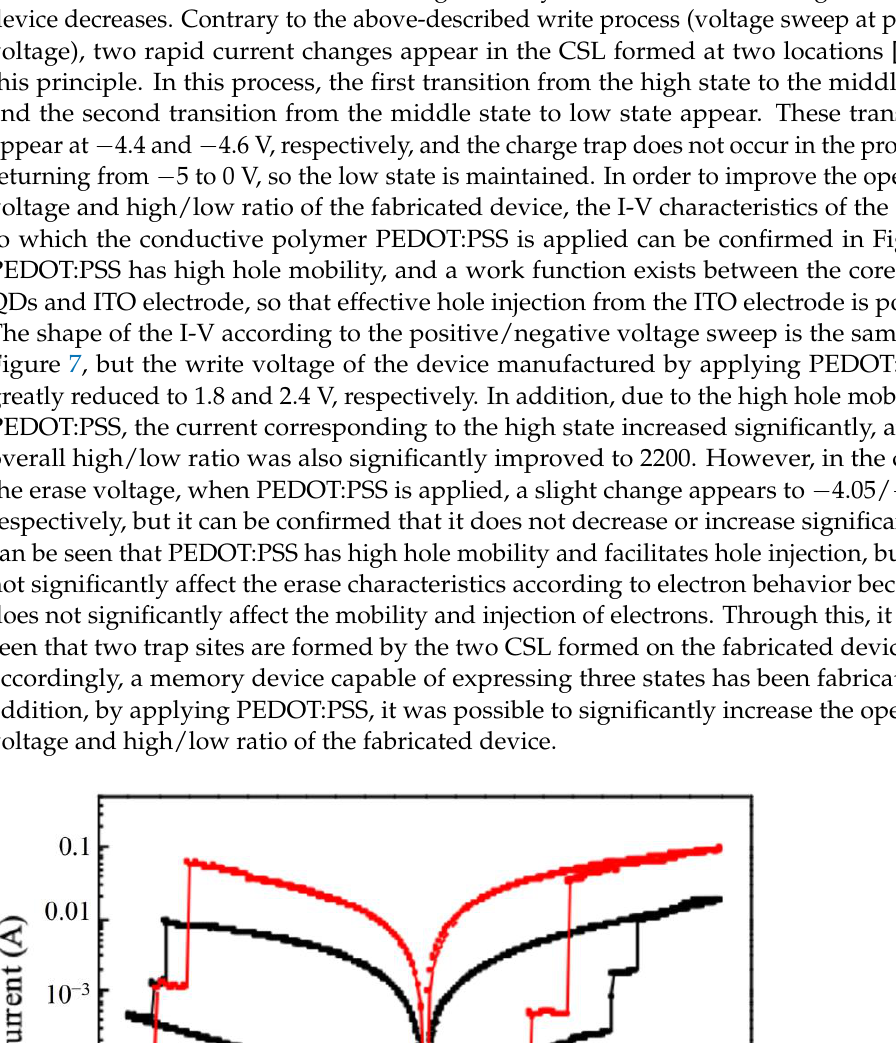
Figure 8. Retention characteristics of the fabricated memory device by measuring the current at 0.5 V after applying write voltage (2/2.7 V).